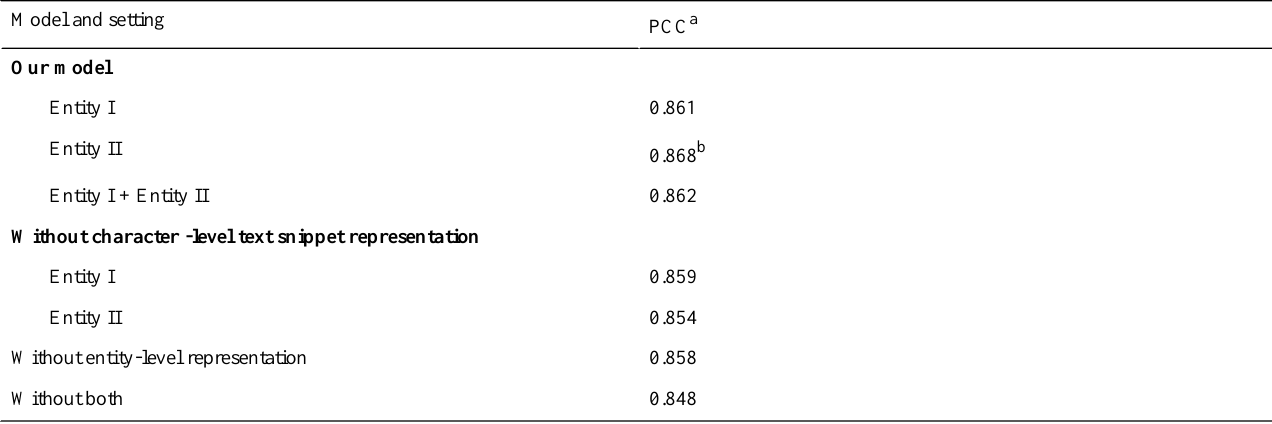
Table 3. Pearson correlation coefficient of our model on the test set.